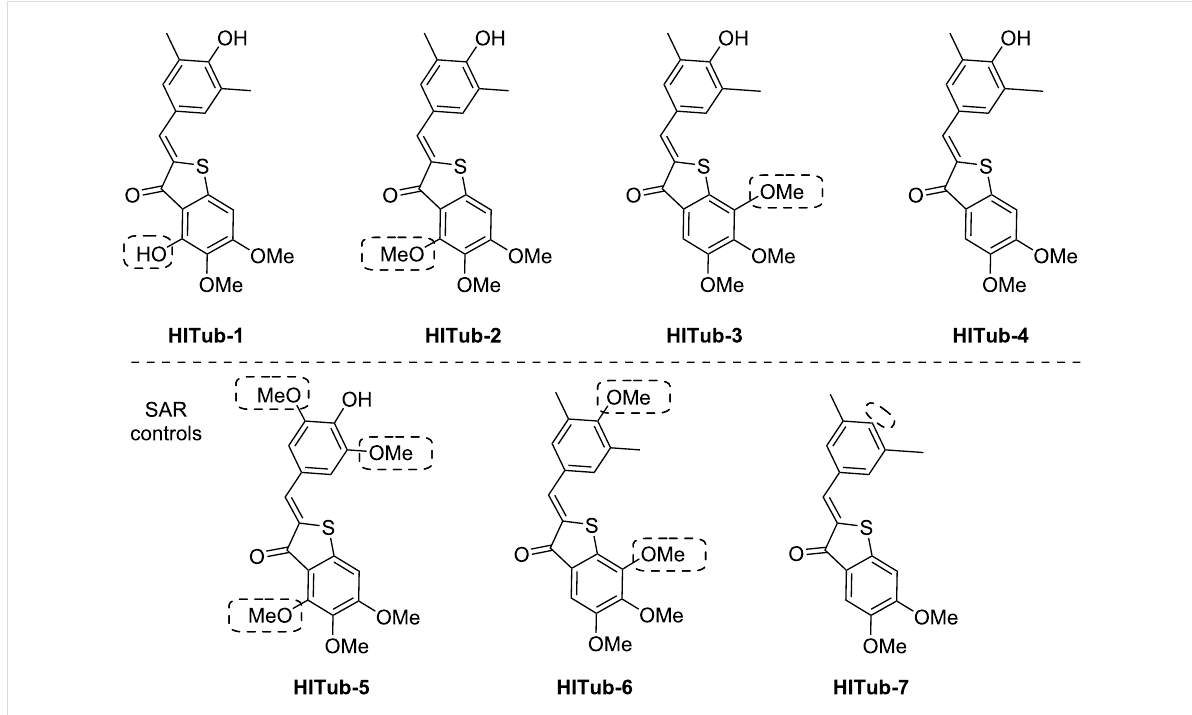
Figure 2: Chemical structures of HITubs . Key variations with respect to HITub-4 are highlighted in dashed boxes.